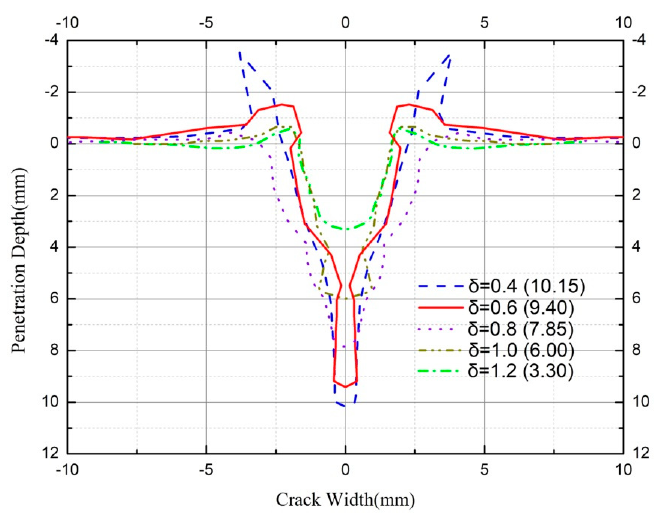
Figure 11. Penetration depth of BLSCs with different liner thickness.